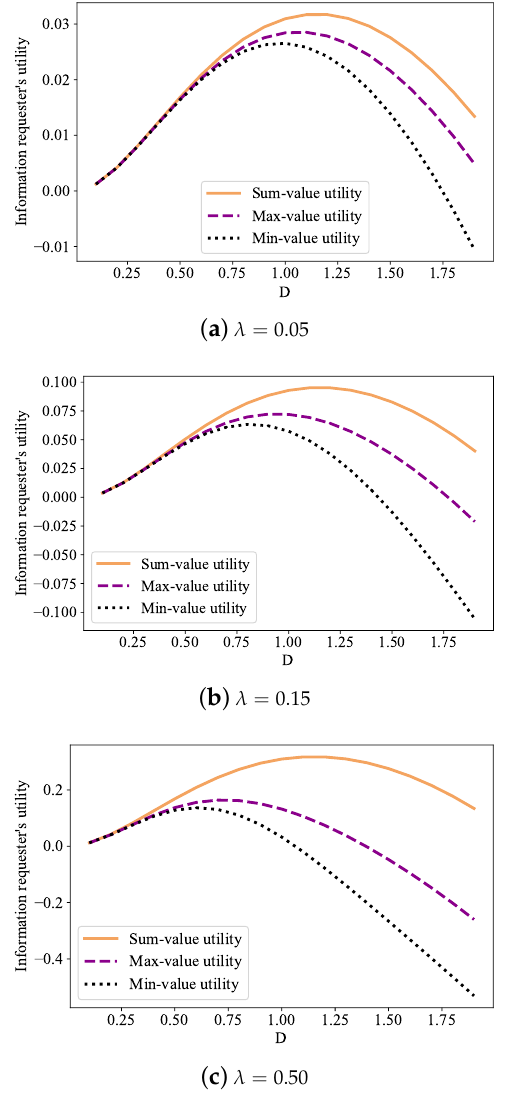
Figure 4. The information requester’s utilities with the sum-, max-, and min-value of information,